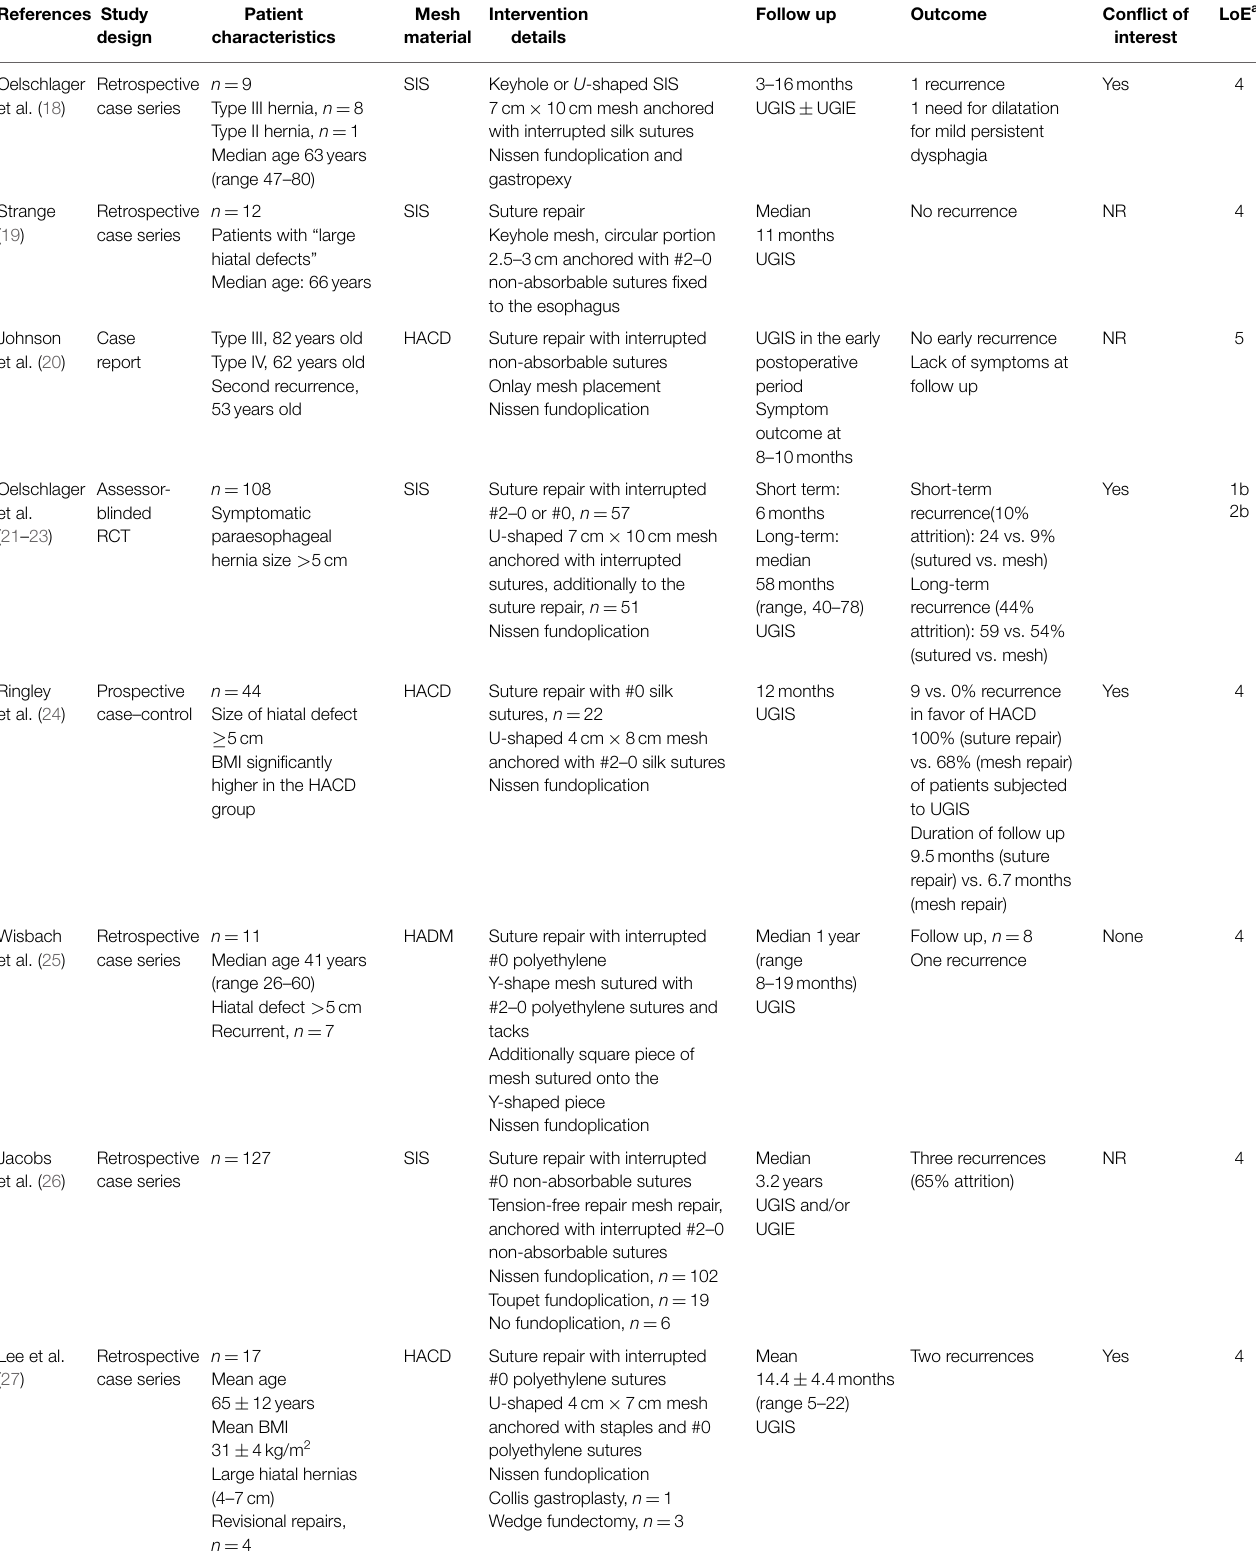
TABLE 2 | Characteristics and outcomes of studies reporting on hiatal hernia repair with the use of biologic mesh